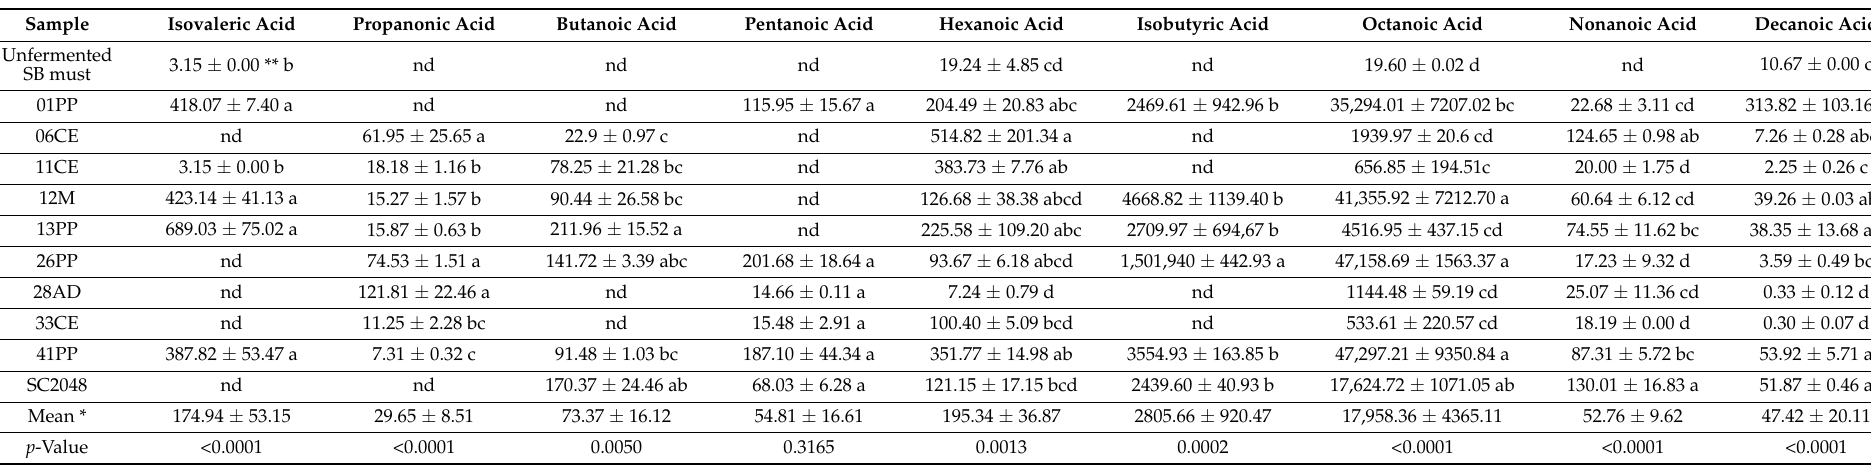
Table 2. Concentration of fatty acids ( µ g/L) in unfermented and fermented Sauvignon Blanc musts. Means ± standard error, followed by the same letter, do not differ according to Tukey’s test considering a 0.05 significance level.